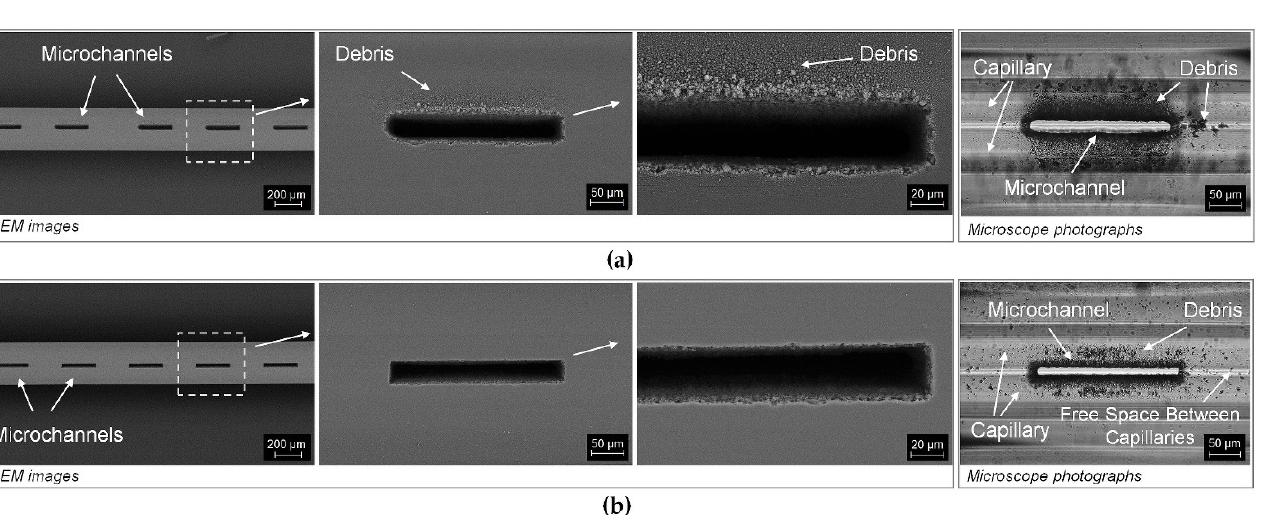
Figure 5. SEM images and microscope photographs of fabricated microchannels using fs laser pulses: ( a ) for the configuration with the F-theta lens and ( b ) for the AL configuration.